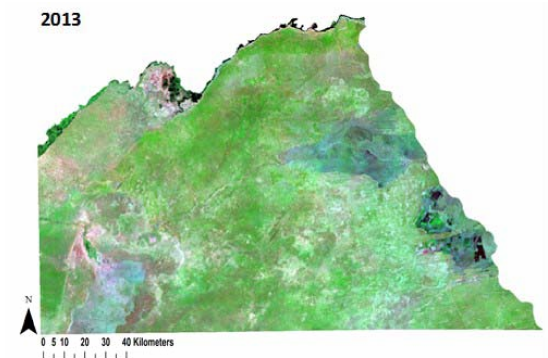
Figure 2. Landsat mosaic images of the study area taken 8–28 April in each year and displayed using a false color 7,4,2 band combination. Healthy vegetation appears green with darker hues indicating forested areas. Water is black to dark blue and pink and magenta indicate bare ground, while sand, soil, and sparsely-vegetated areas appear in lighter shades of pink and